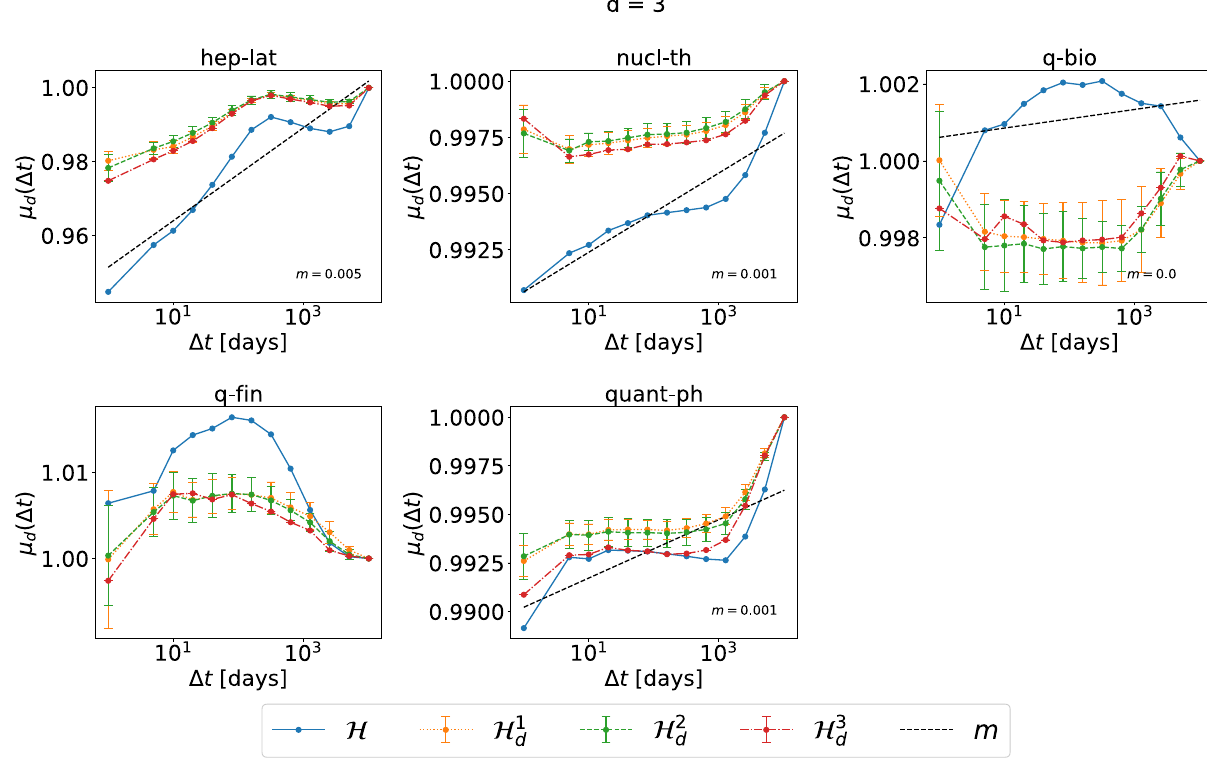
E [ η( e , e ′ ) | T ( e , e ′ )<� t , e ∈ E d , e ′ ∈ E \ E d ] Figure 2. The normalized average topological distance µ d (� t ) = E [ η( e , e ′ ) | e ∈ E d , e ′ ∈ E \ E d ] , between an order d = 3 event and an event of a different order, in each collaboration network and its corresponding three randomized null models H 1 d (yellow), H 2 d (green) and H 3 d (red), which preserve or destroy specific properties of order d = 3 events. lim � t →∞ E [ η( e , e ′ ) | T ( e , e ′ ) < � t , e ∈ E d , e ′ ∈ E \ E d ] = E [ η( e , e ′ ) | e ∈ E d , e ′ ∈ E \ E d ] for any d . The horizontal axes are presented in logarithmic scale. The dashed line in each figure corresponds to the linear fit (with slope m ) of µ d (� t ) as a function of log 10 (� t ) in H , for the part that the curve has an increasing trend. For each dataset, the results of the three corresponding randomized models are obtained from 10 independent